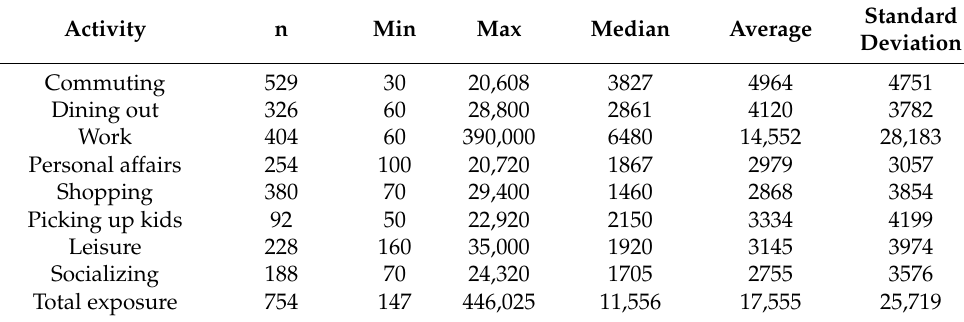
Table 3. Exposure risk level of all activities within a week.